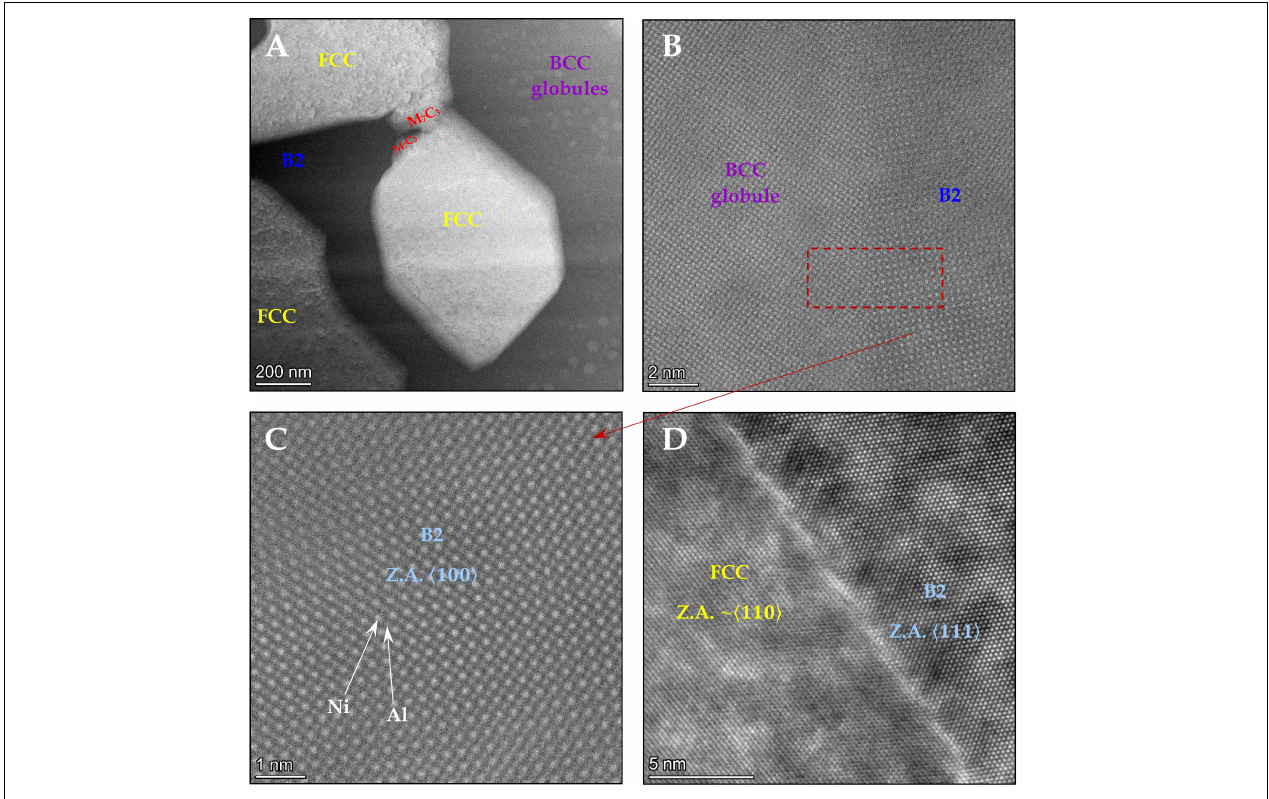
FIGURE 3 | (A) STEM image taken from the dashed square region in Figure 1B showing the brighter globules compared with the darker B2 background; (B) HAADF showing a lattice image in the < 100 > zone axis of the BCC and B2 domain, and the characteristic order-disorder transition through the interface between the B2 phase and the BCC globules; (C) HAADF of the B2 parent phase in the < 001 > zone axis showing the ordering of Ni and Al atoms in the lattice; (D) HAADF image showing the interface between an FCC particle and the B2 phase – demonstrating the near perfect Kurdjumov-Sachs orientation relationship.